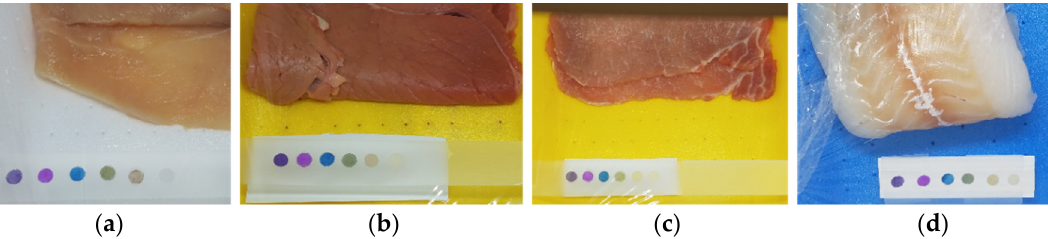
Figure 1. An example of the array placed over trays containing chicken meat ( a ), beef meat ( b ), pork meat ( c ) and codfish ( d ).